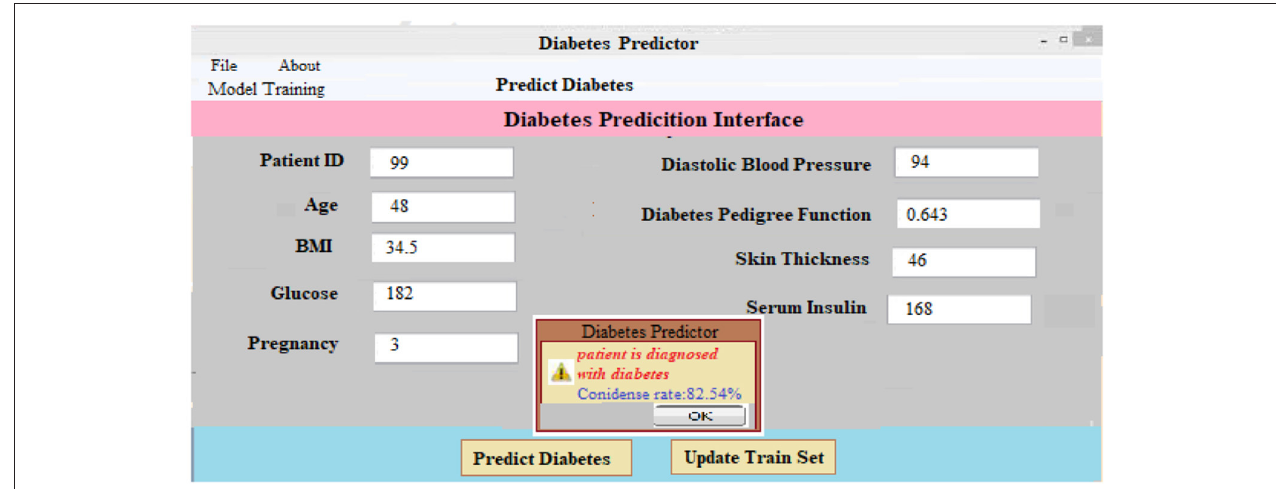
FIGURE 7 | Diabetes prediction interface.